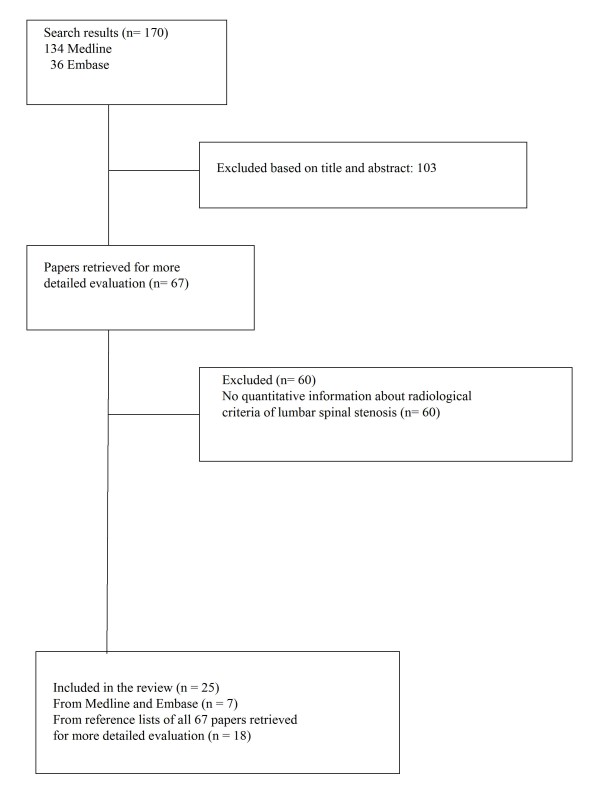
Flowchart of search results in Medline, Embase and bibliographies.